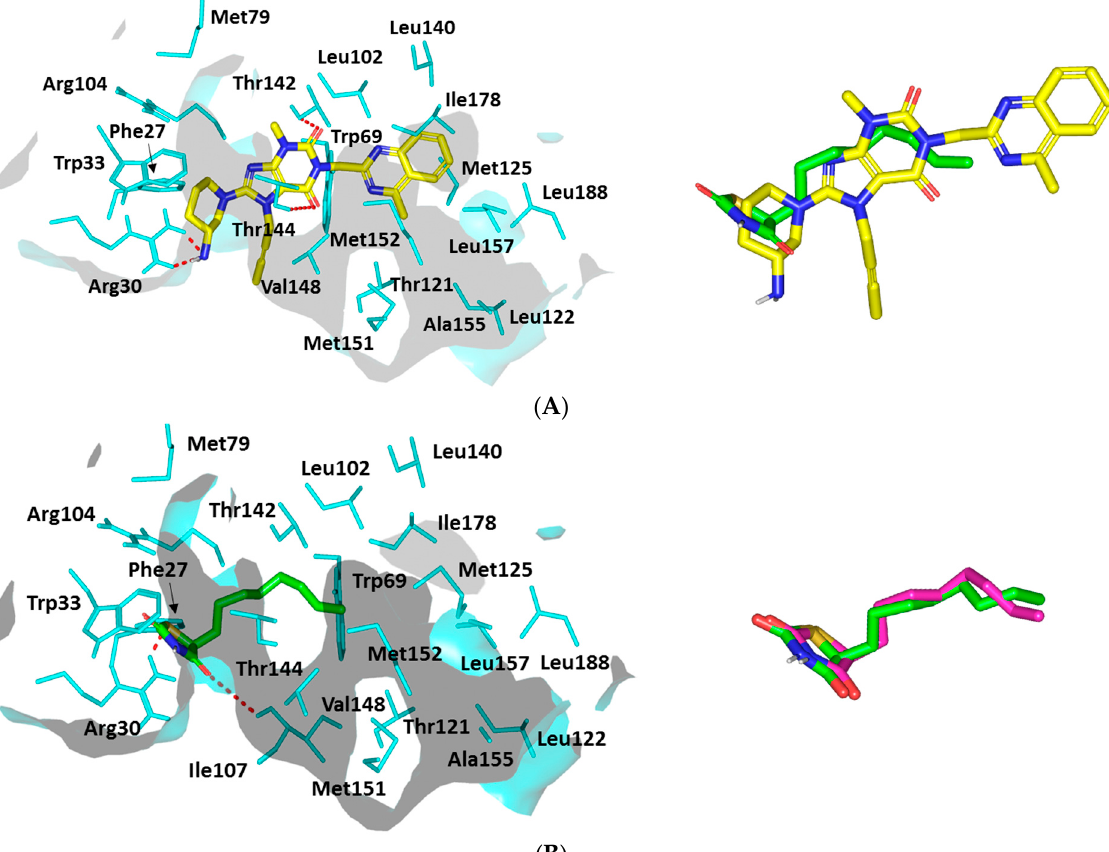
Figure 10. Ligand-protein binding interactions at Pseudomonas aeruginosa LasI synthase binding site. Predicted binding modes of the docked ligands ( A ) LIN and ( B ) TZD-C8 as cyan and green sticks, respectively. Only residues located within 5 Å radius of bound ligands are displayed (cyan lines) and labeled with a sequence number. Non-polar hydrogens are removed for clarity and hydrogen bonds are depicted as red dashed lines. The right panels are an overlay of LIN and docked reference standard, TZD-C8, as well as, the docked reference ligand and its re-docked state (magenta sticks).